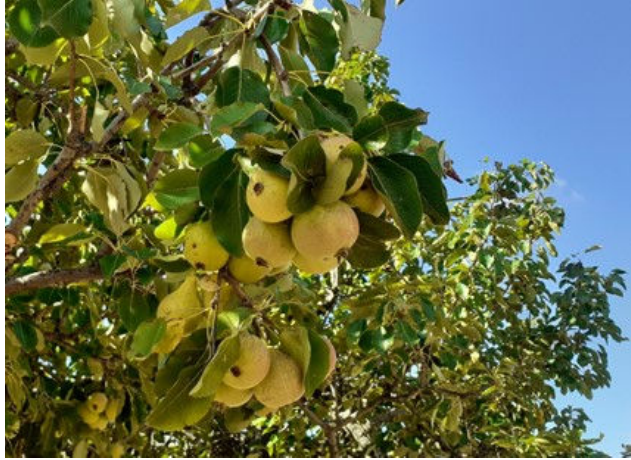
Figure 3. Fruits of Spadona cultivar to be harvested in early October. Fruits, free of defects and mechanical damage, were selected and each subsample was constituted by 10 homogeneous pear fruits replicated 3 times. They were manually peeled, and four wedges were cut vertically from each side. The flesh, the peel, the core (without seeds), and the peduncle (Figure 4) were frozen separately at −20 °C, before being freeze-